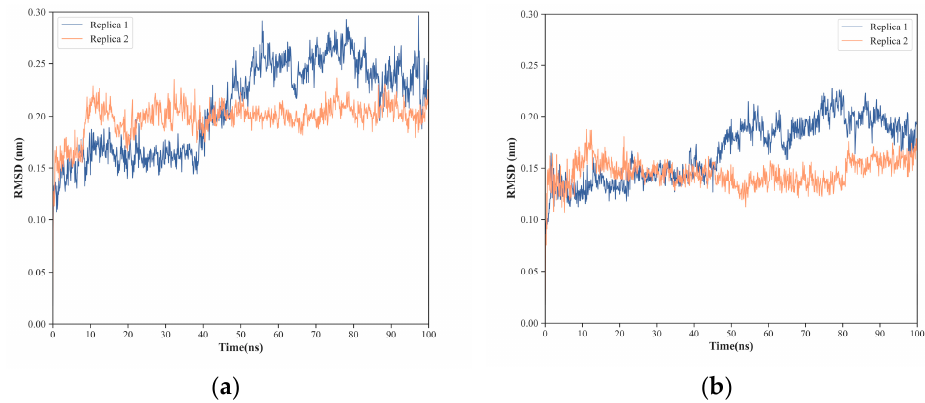
Figure 9. C α atoms RMSD for the residues in the interface of the complex between NS1 and TRIM25, considering the residues from both NS1 and TRIM25 ( a ) or just the residues from NS1 ( b ).